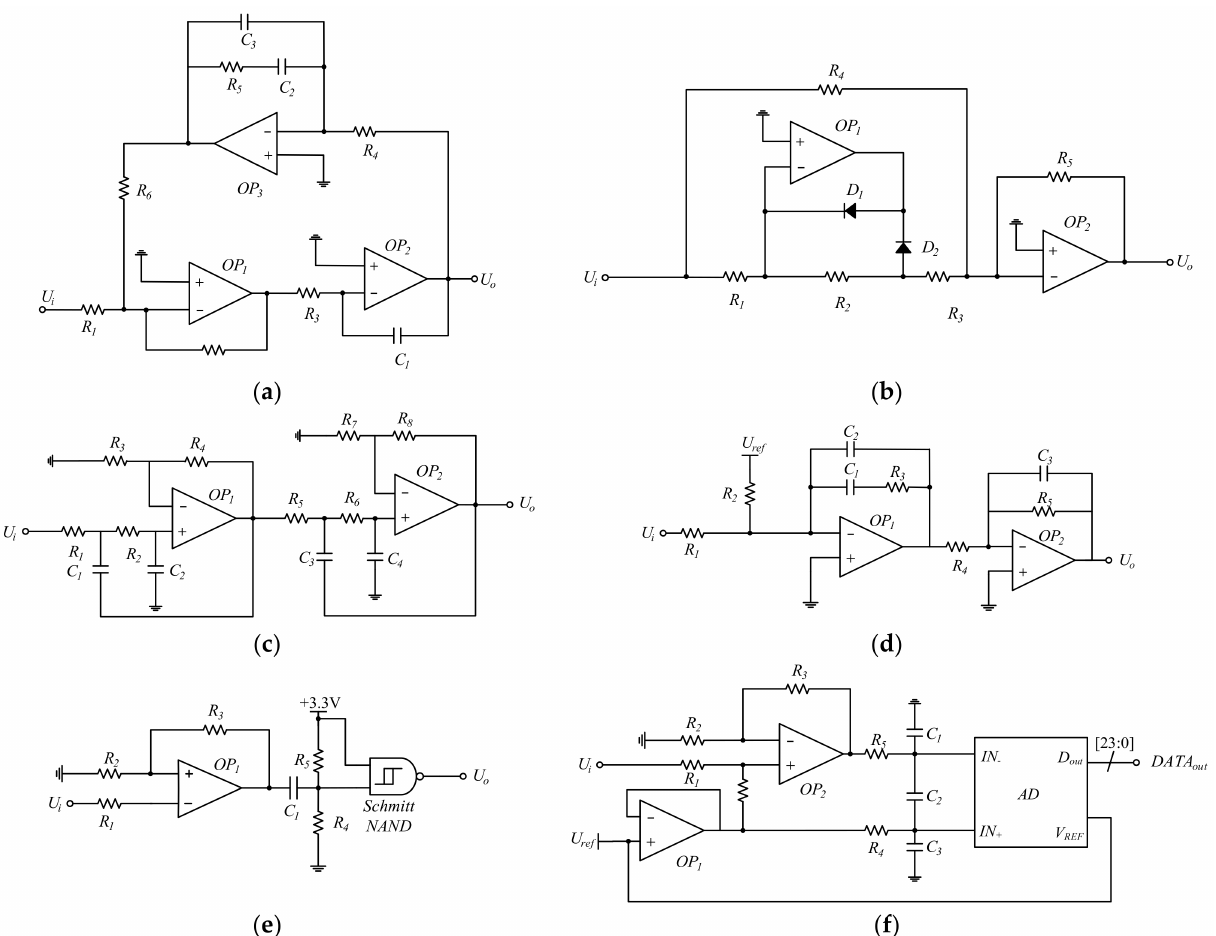
Figure 7. The specific circuit of some modules. ( a ) 90 ◦ phase shifter; ( b ) rectifier circuit; ( c ) low-pass filter; ( d ) PI controller; ( e ) range change and shaping circuit; ( f ) range change and AD